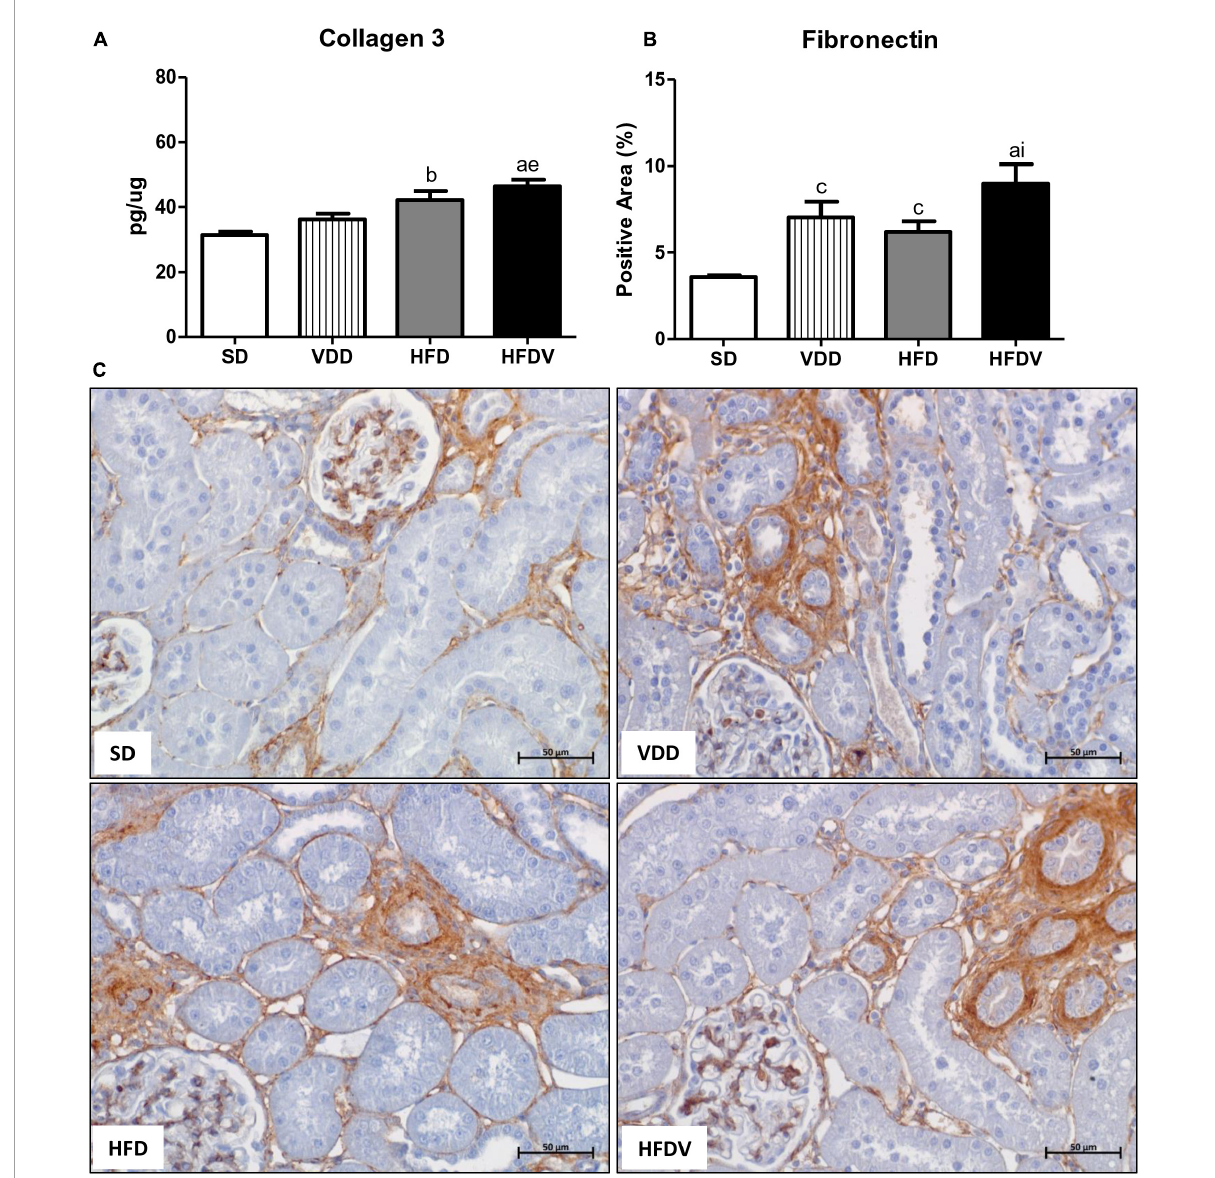
FIGURE8 Quantitative amount of collagen 3—ELISA and immunohistochemical analysis for fibronectin expression in the kidney tissue evaluated after the 90-day protocol in rats submitted to renal ischemia-reperfusion insult on day 45 treated with standard diet (SD), vitamin D-free diet (VDD), high-fat diet (HFD), or high-fat vitamin D-free diet (HFDV). Bar graphs of (A) collagen 3 and (B) fibronectin expression values. (C) Representative photomicrographs of immunostaining for fibronectin in the renal cortex from an SD, VDD, HFD, and HFDV rat (400 × ). Data are mean ± SEM. a p < 0.001, b p < 0.01 and c p < 0.05 vs. SD; e p < 0.01 vs . VDD; i p < 0.05 vs .